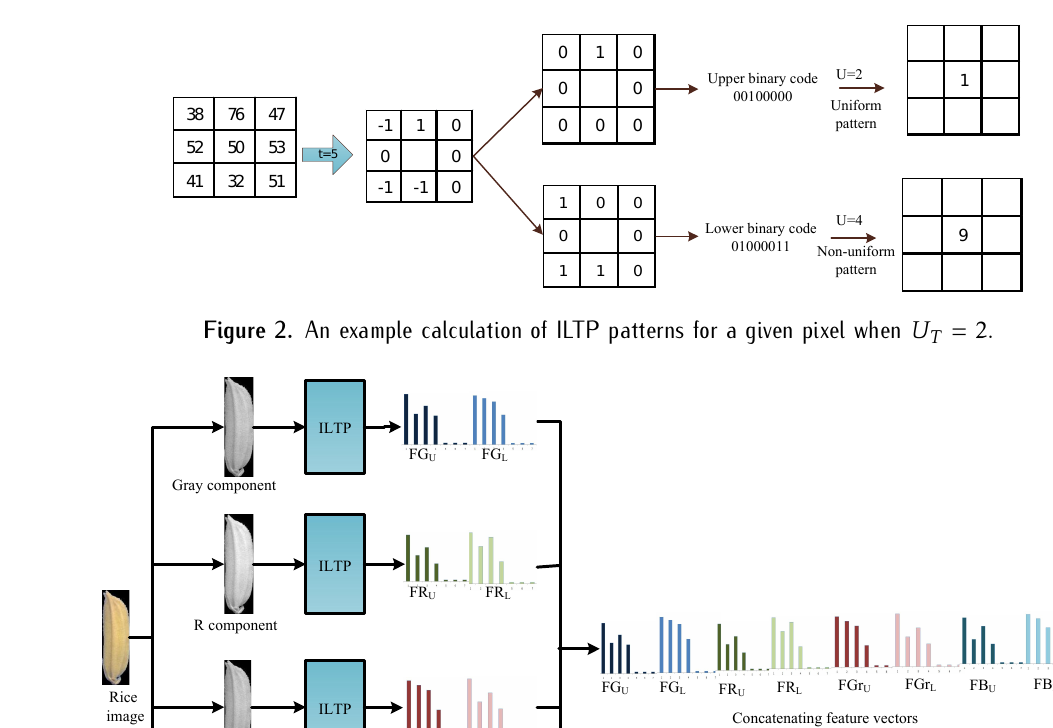
Figure 3. The analysis procedure for texture color using the proposed